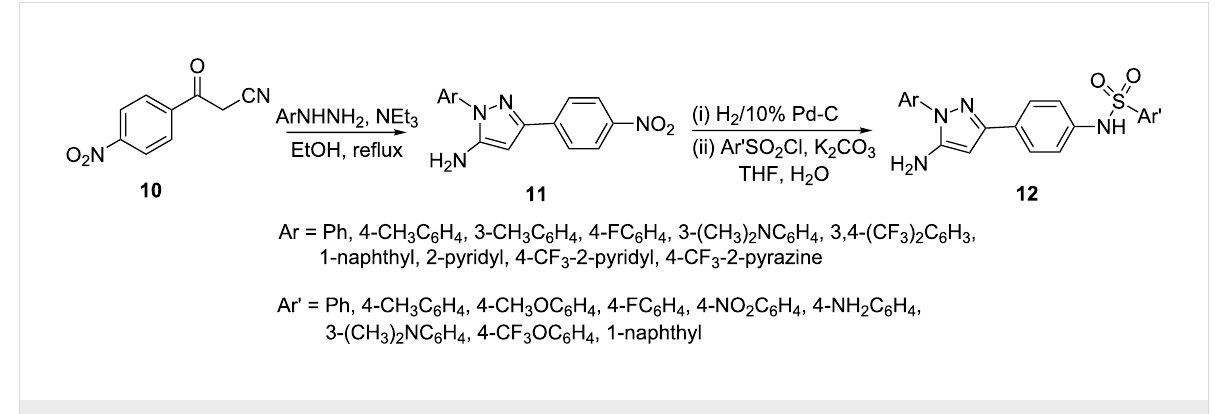
Scheme 4: Synthesis of 5-aminopyrazoles and their sulfonamide